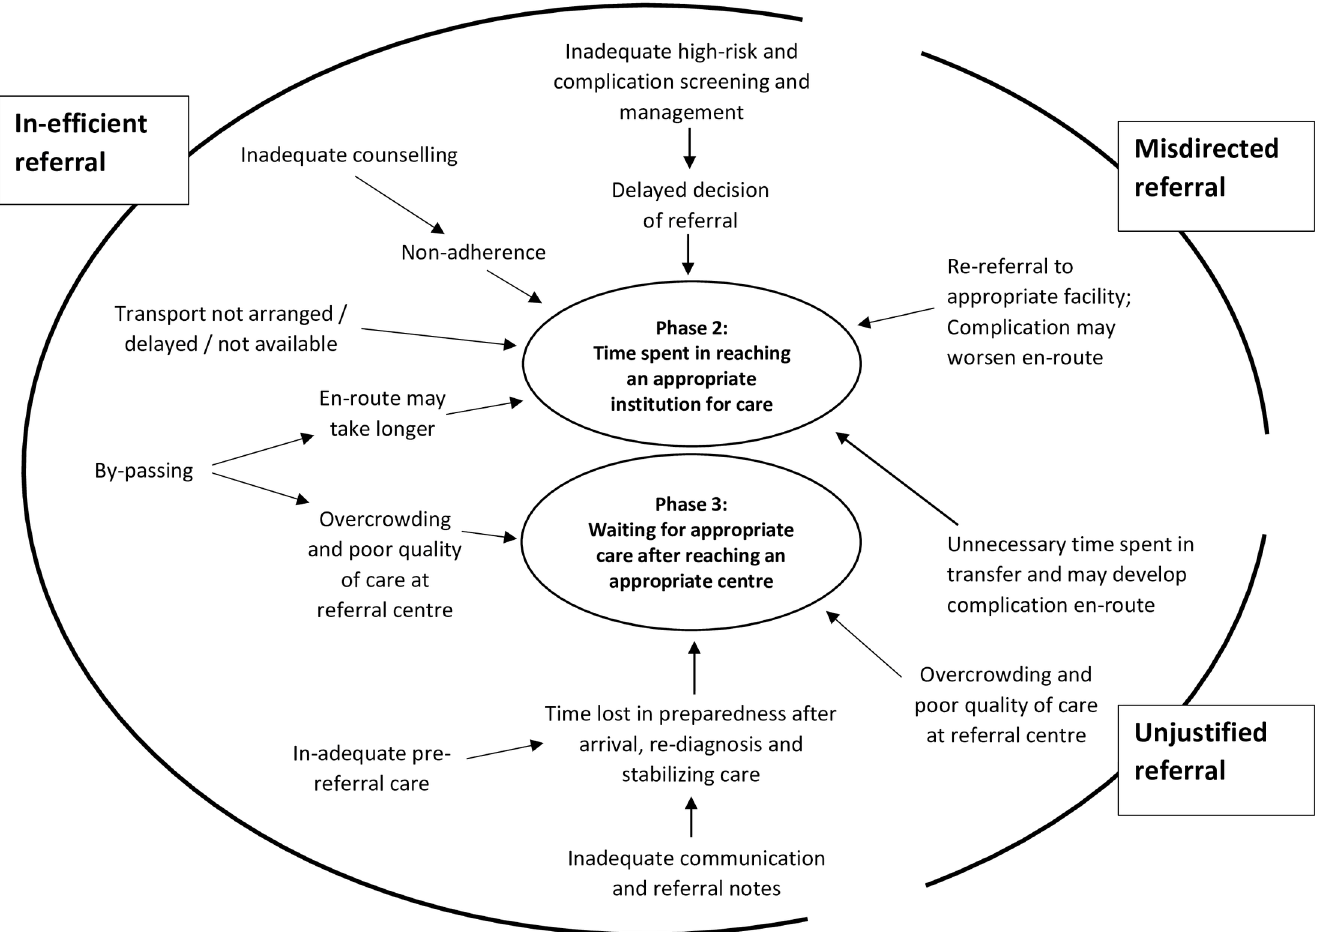
Fig 3. Inappropriate institution-referrals and contribution to delays in access to emergency obstetric care. doi:10.1371/journal.pone.0159793.g003 PLOS ONE | DOI:10.1371/journal.pone.0159793 August 3,